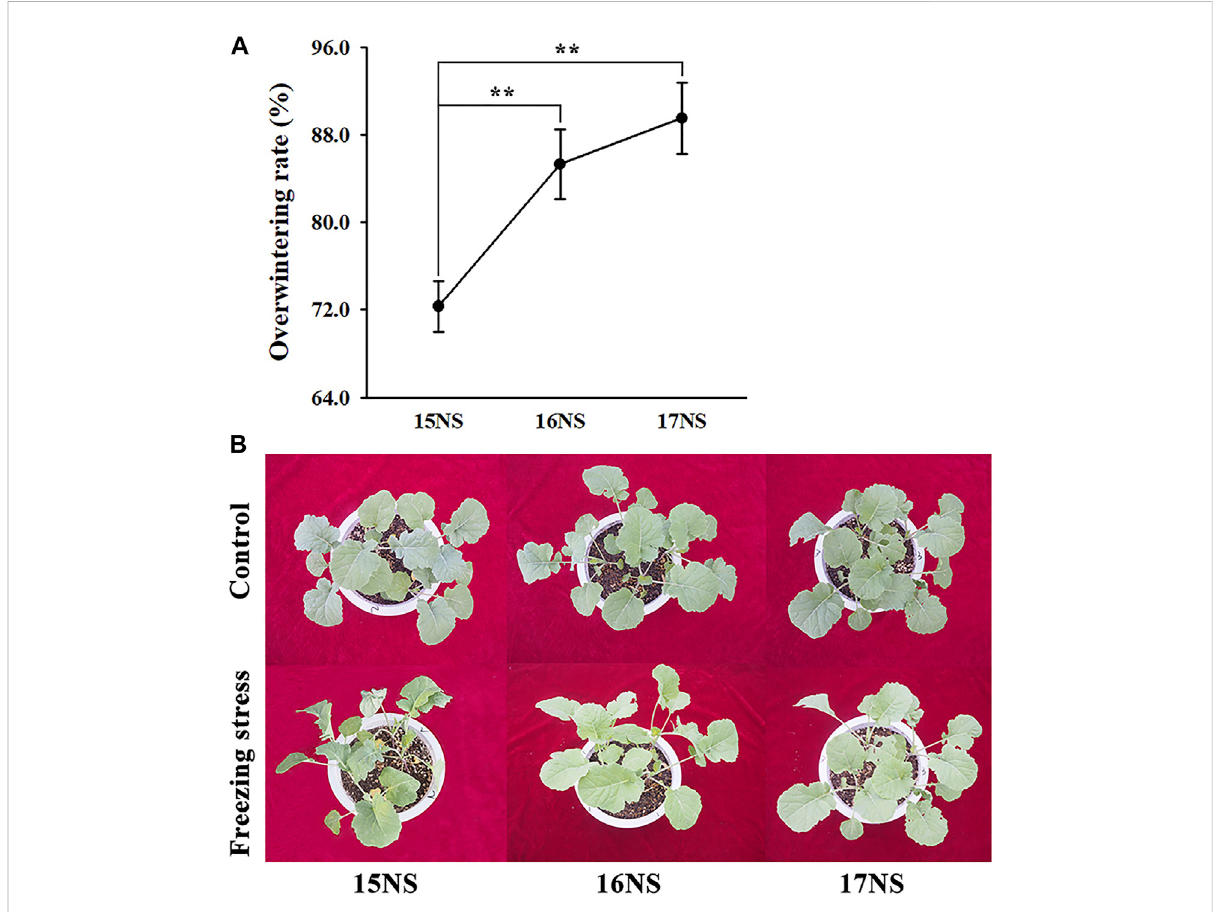
FIGURE 1 Overwinteringrateandmorphologicalchangesinwinterrapeseed seedlingunderfreezing stress. (A) , Overwintering rate ofrapeseedNSunder freezing treatment. Values are means± SD from threebiological replicates (**, p < 0.01); (B) , Illustrationof 5-week-old winterrapeseed plants under freezing treatment cultivated in 2015, 2016 and